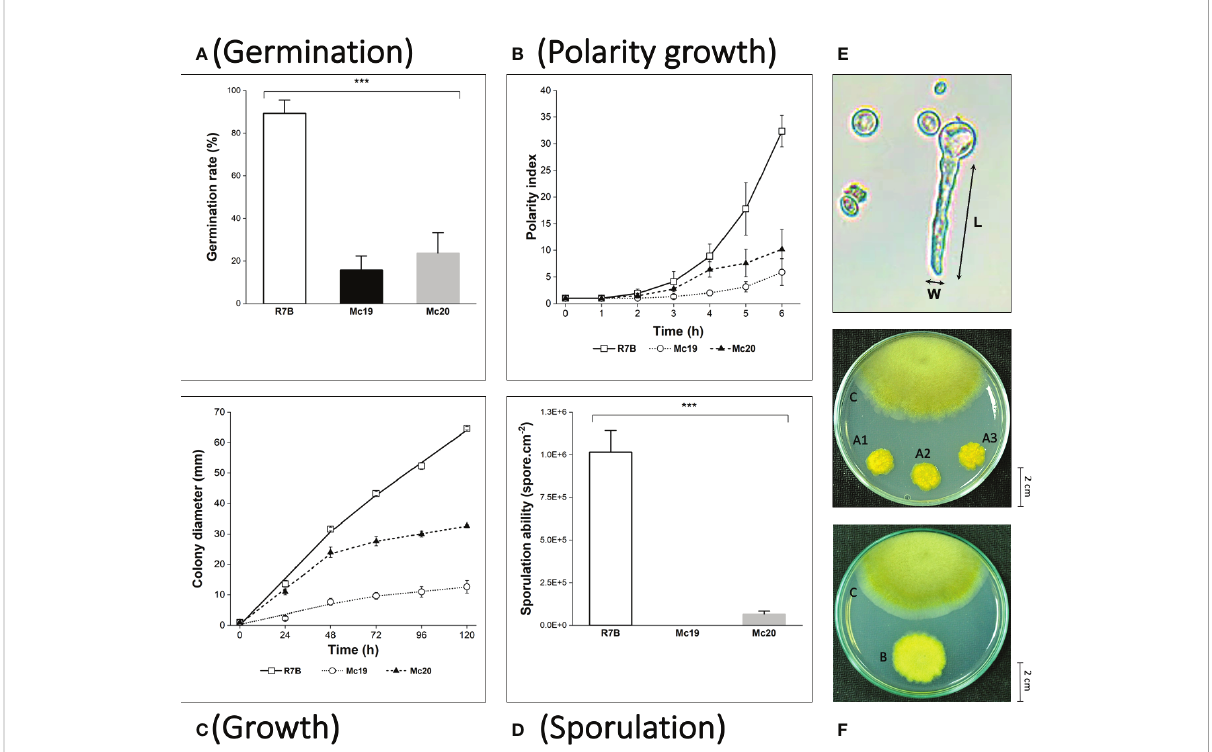
FIGURE 4 Phenotypic analyses of the myosin II null mutants D mcmyo2A (Mc19) and D mcmyo2B (Mc20). The analysis includes quanti fi cation of germination at the 6 h of incubation in MMC liquid media (pH 4.5) (A) , polarity growth (B) , hyphal growth (C) , and vegetative sporulation (D) (***p<0.001). (E) The calculation of the polarity index representing polarity growth: cell length (L) divided by cell width (W). Small pieces of grown mycelia of each strain were grown in MMC medium plates (pH 3.2) at 26°C under a continuous light condition for 120 hours in the growth rate measurements. In the case of sporulation assessment, the inoculated fungi were incubated for 72 hours to collect the total vegetative spores. (F) Colonies of Mc19 (A1 – 3) and Mc20 (B) , compared to the control R7B strain (C) at 96 h of incubation. Colonies were grown on MMC media (pH 3.2) at 26°C under a continuous light